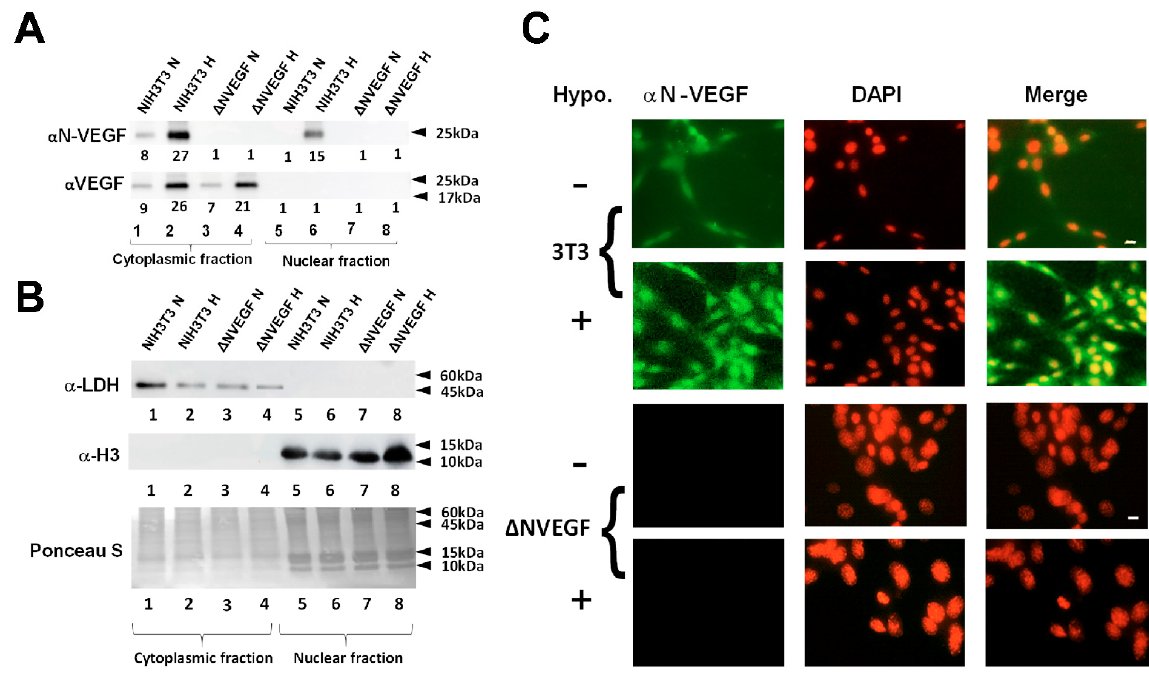
Figure 3. Genomic deletion of N-VEGF using CRISPR-Cas9. ( A ) Cytoplasmic and nuclear fractions were prepared from NIH3T3 and N-VEGF deleted cells ( Δ NVEGF). Western blots were performed were prepared from NIH3T3 and N-VEGF deleted cells ( ∆ NVEGF). Western blots were with antibodies directed against N-VEGF and VEGF showing complete deletion of endogenous N-